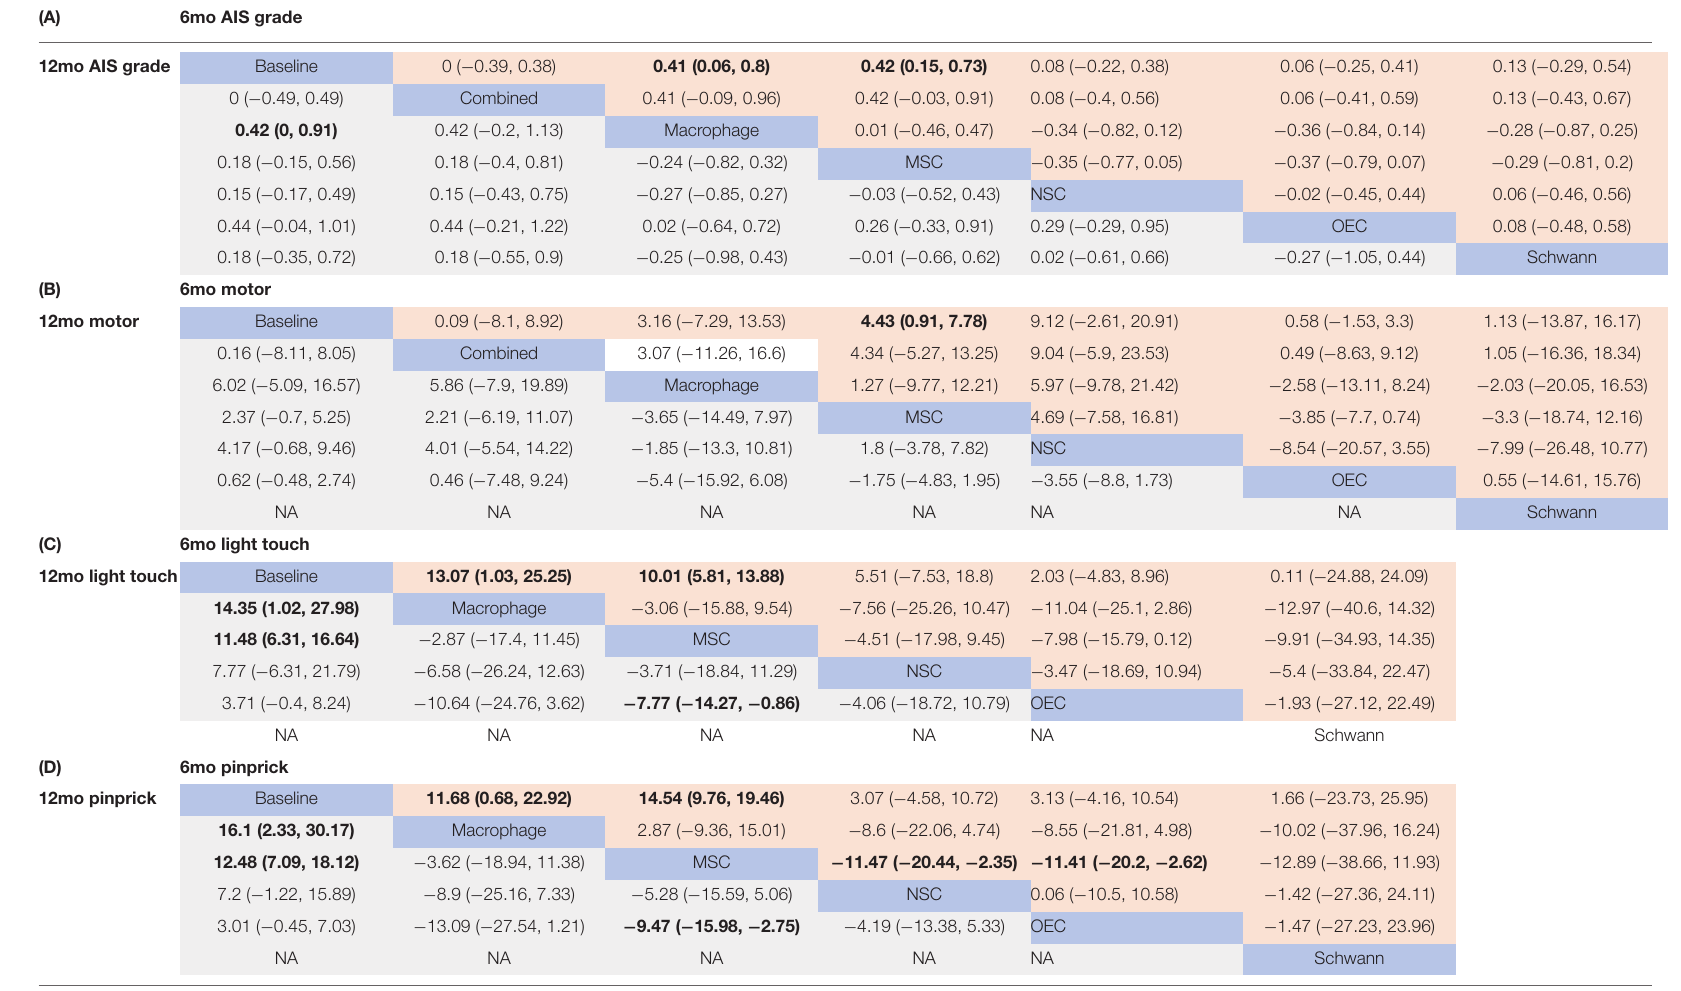
TABLE 2 | Pooled estimates of the network meta8-analysis for the outcome “6mo and 12mo AIS grade” (A), “6mo and 12mo ASIA motor score” (B), “6mo and 12mo ASIA light touch score” (C), “6mo and 12mo ASIA pinprick score” (D), “6mo and 12mo FIM score” (E), and “6mo and 12mo IANR-SCIFRS” (F).